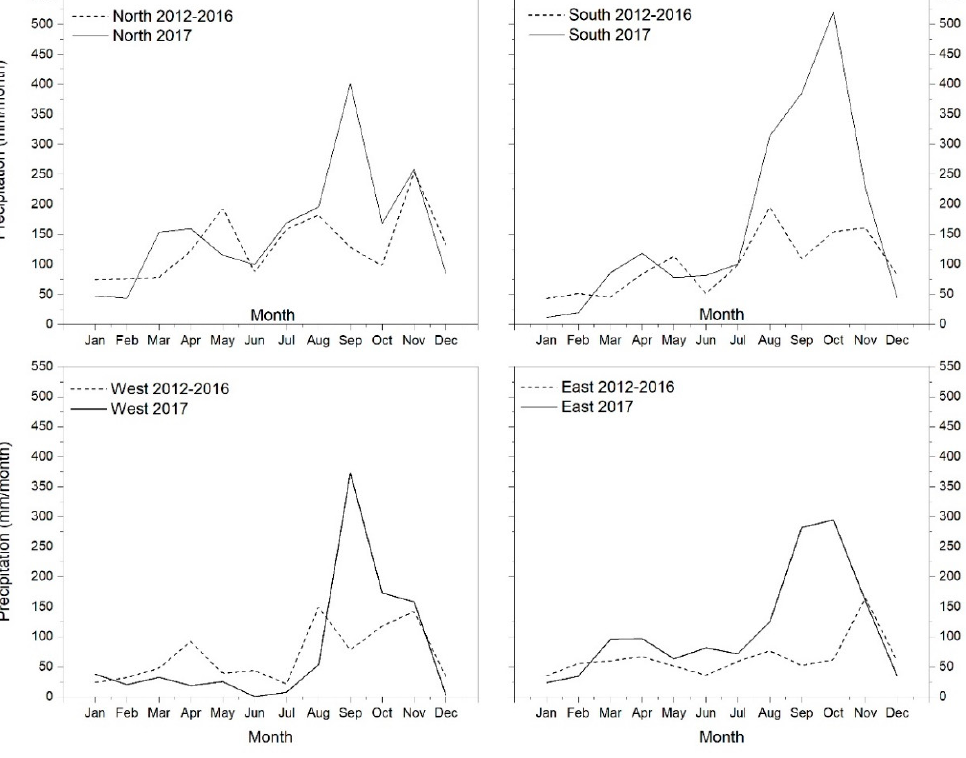
Figure 4. Monthly averaged precipitation for the North, South, West, and East during 2012–16 baseline period and for 2017.